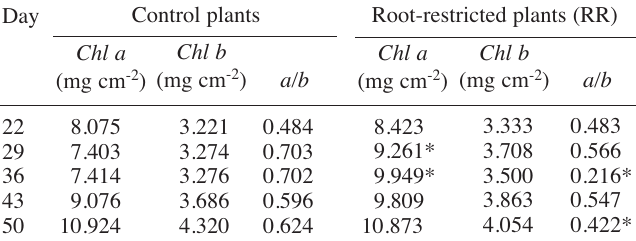
* indicates significantly different values between the two treatments for the same parameters for P≤0.05 (n=5), when means were sepa- rated by Duncan’s test.